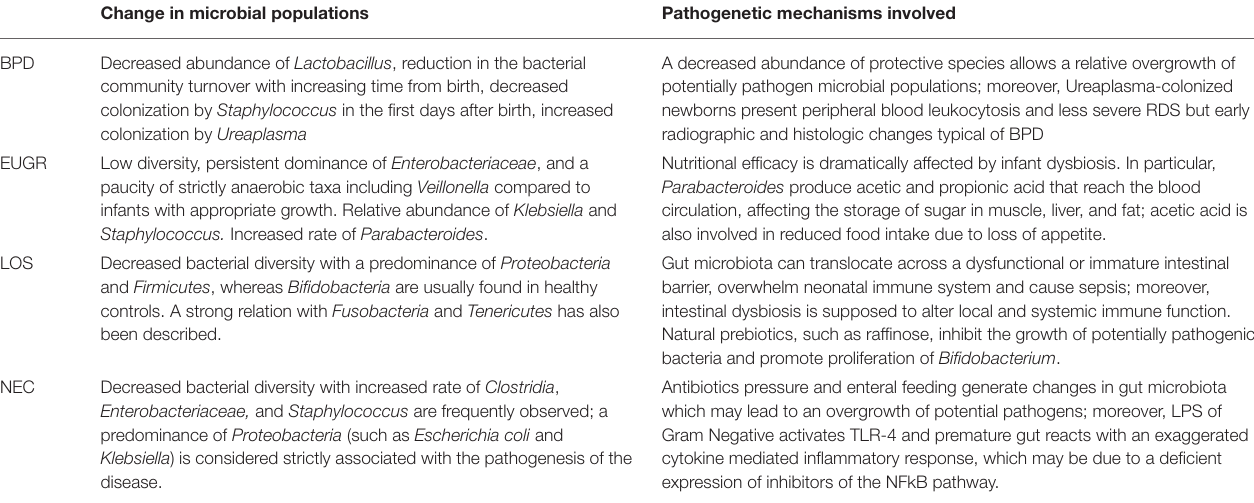
TABLE 2 | Summary of the changes in microbial resident population observed in the different pathologic conditions and the underlying pathogenetic mechanisms. Change in microbial